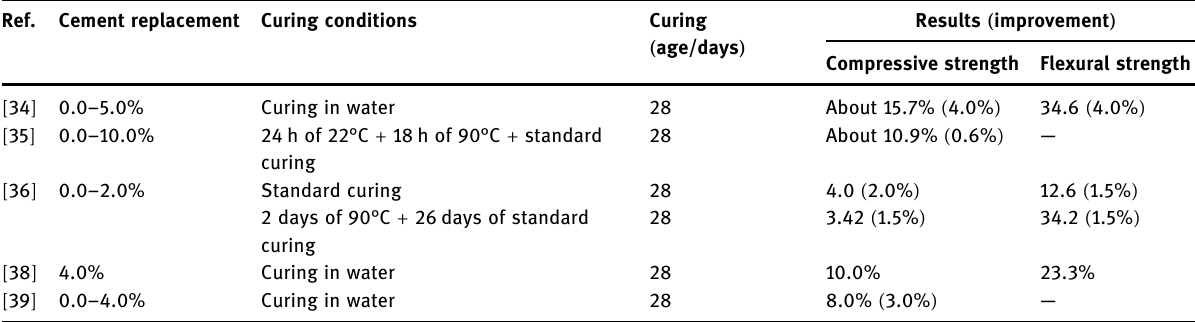
Table 1: E ff ect of nano - silica on mechanical properties of UHPC Ref. Cement replacement Curing conditions Curing